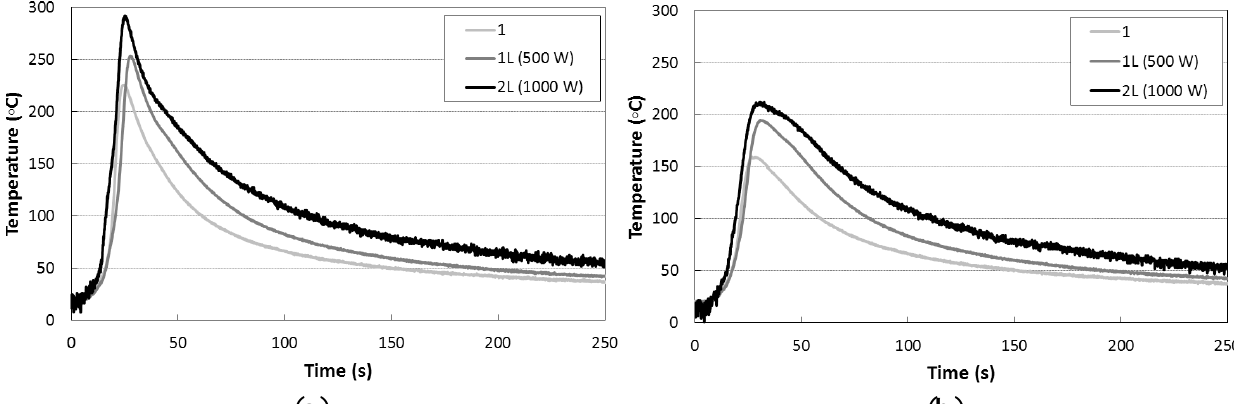
Figure 12. Temperature history during welding process at different distances from the cord. ( a ) Temperature vs. time at 1 cm from weld joint; ( b ) temperature vs. time at 2 cm from weld joint and ( c ) temperature vs. time at 3 cm from weld